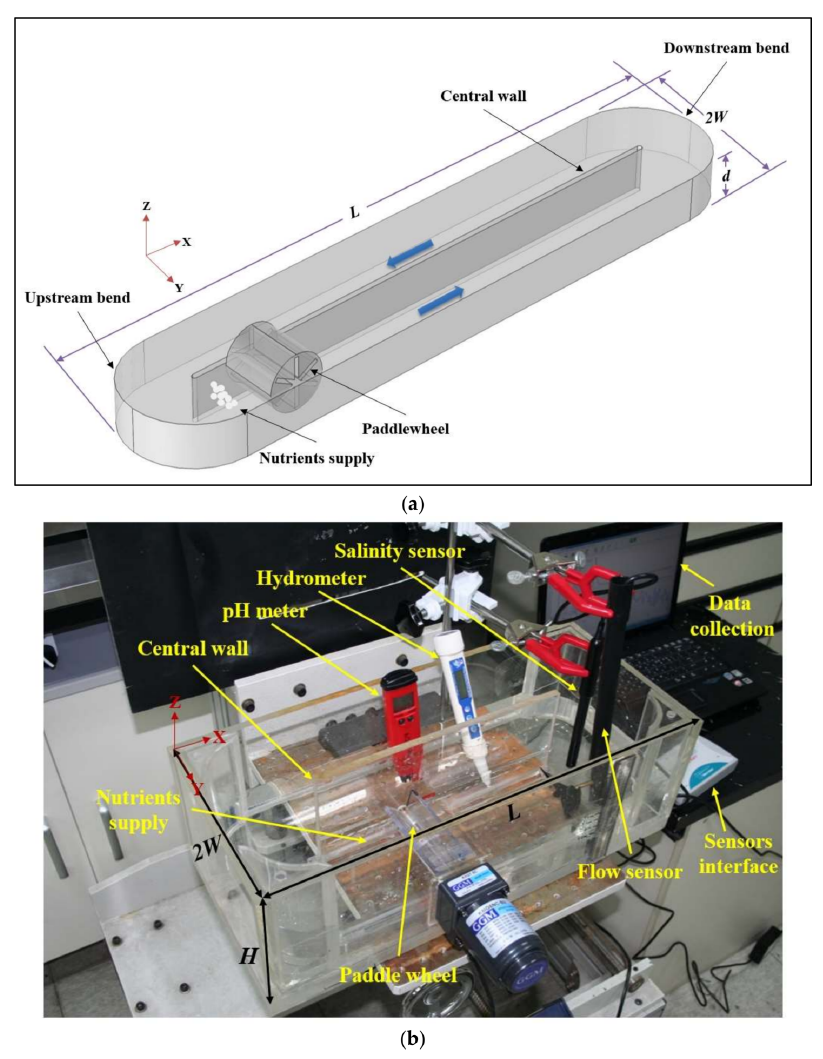
Figure 1. Computational fluid dynamics (CFD) model ( a ) and Laboratory set-up ( b ) of the raceway